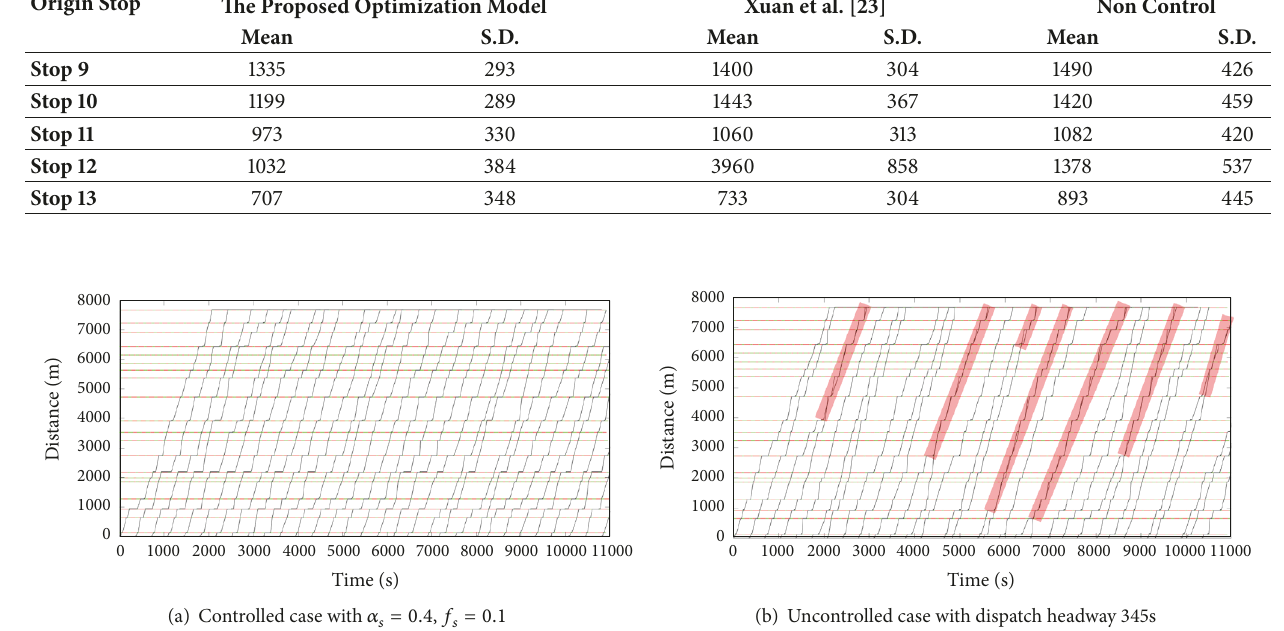
Figure 6: Bus trajectories under the proposed holding control and uncontrolled situation.